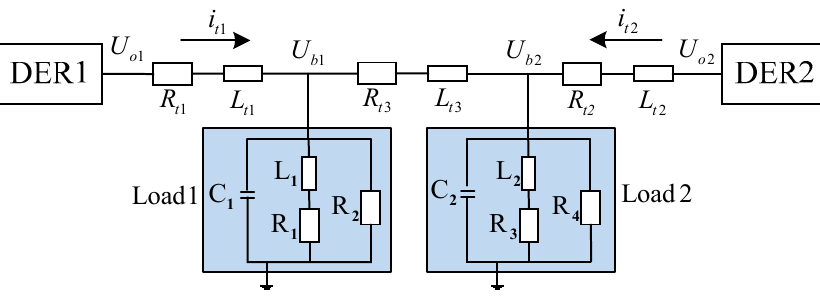
Figure 4. Circuit model of the connected DERs. R: resistive load; C: capacitive load; L: inductive load.